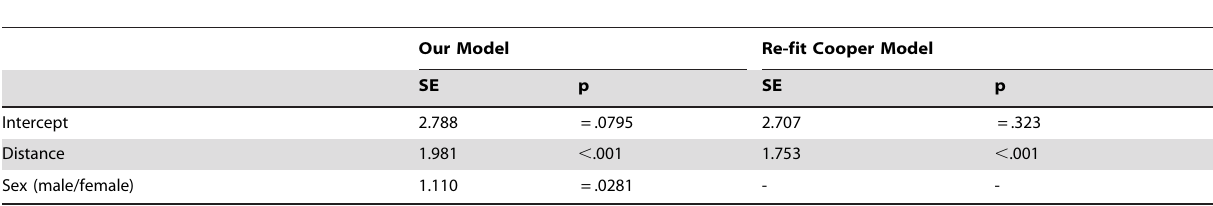
Table 3. Standard errors and p values for our model and the re-fit Cooper model developed to predict relative VO (ml ? kg 2 1 ? min 2 1 ) from a 12-minute run/walk